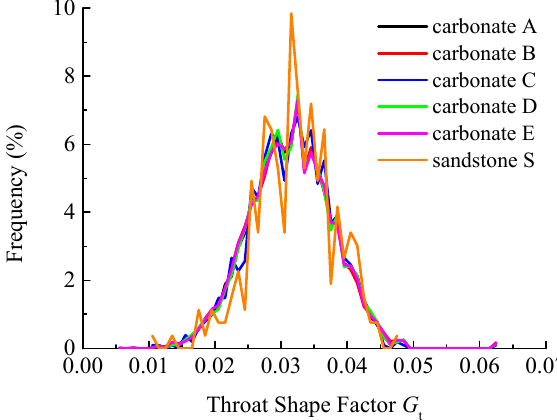
Figure 19. Distribution of throat shape factors of REV2s of test samples.